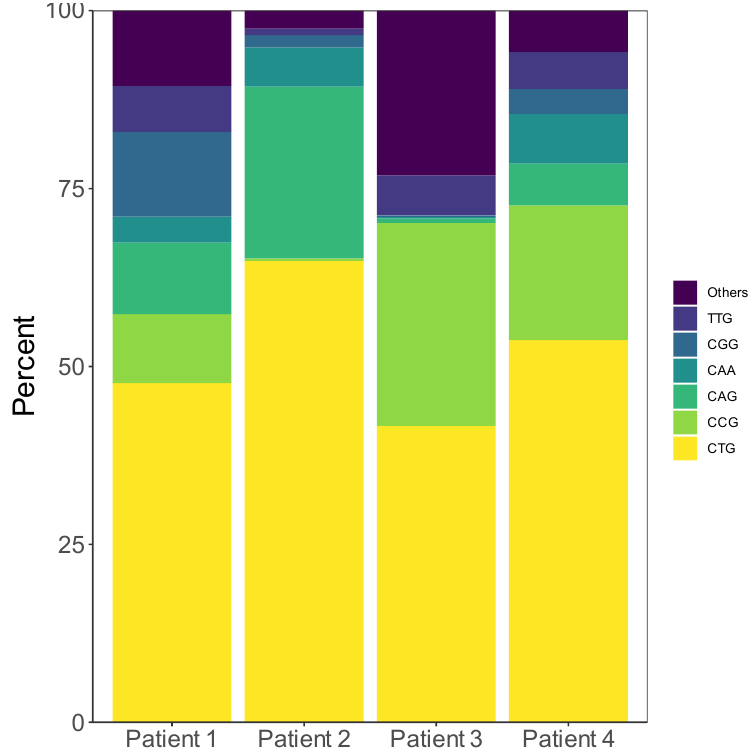
Figure 3. Distribution of the most common triplets in the expanded repeats of each patient.